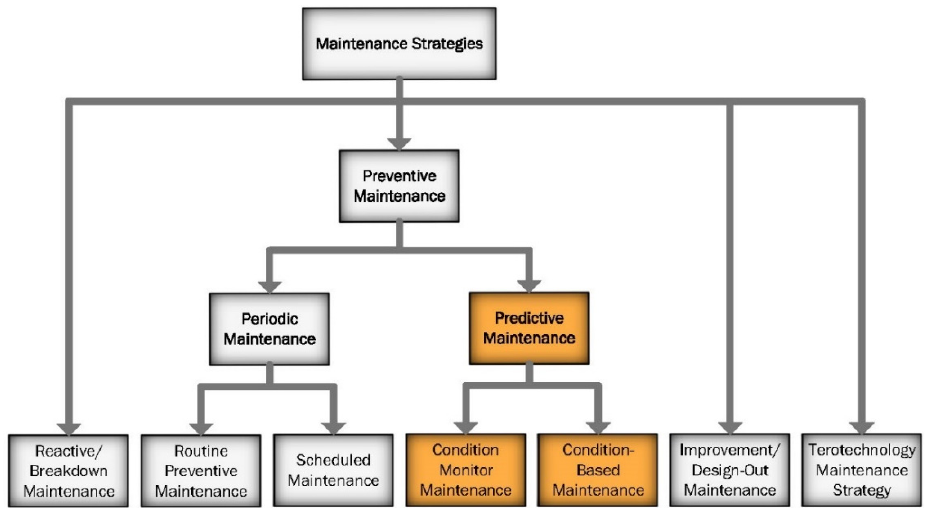
Figure 2. Structure of maintenance management strategies.